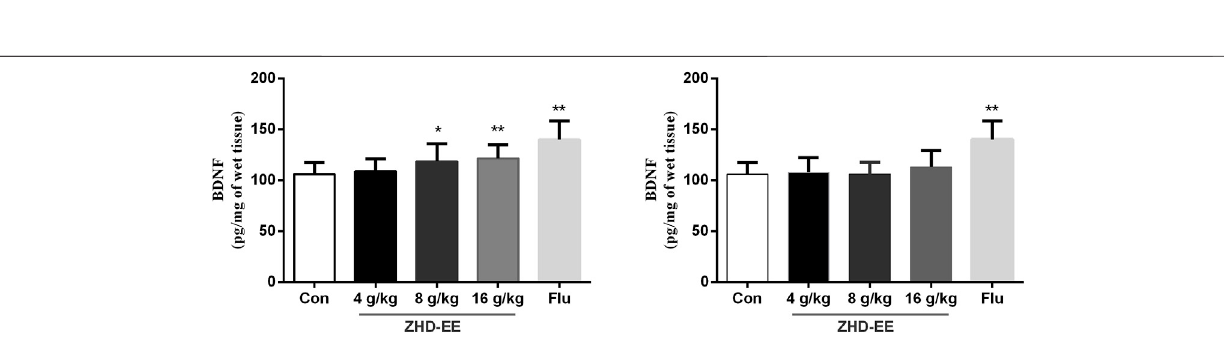
Frontiers in Pharmacology |